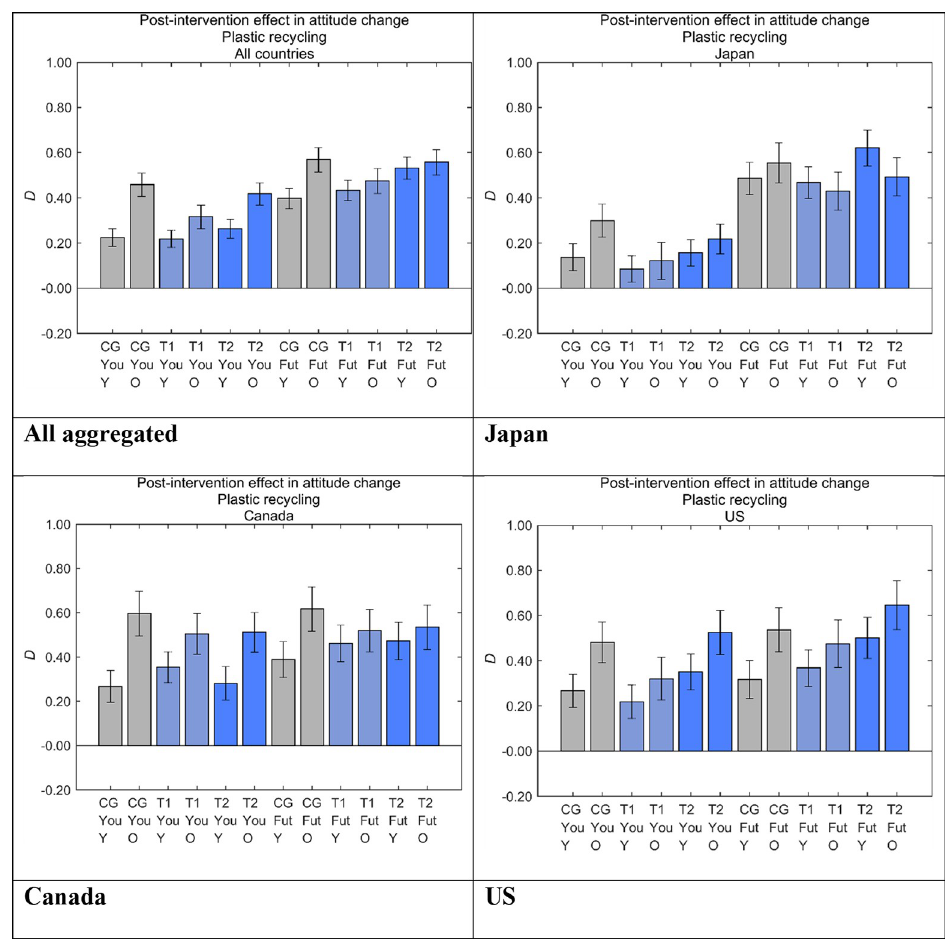
Fig 15. Post-intervention effect in attitude change toward disposable plastics ( D ) by age. Error bars show 95% confidence intervals. Higher values on the vertical axis indicate lower perceived danger of plastic recycling. CG, control group; T1, treatment group 1; T2, treatment group 2; Fut, Future Generations; You, Yourself; Y, respondents under the age of 50 years; O, respondents 50 years of age and older.